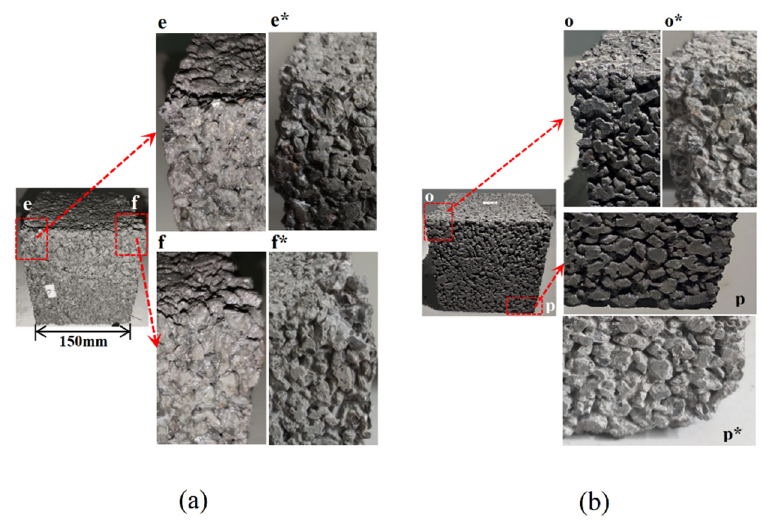
Figure 3. Change of pervious concrete morphology under different freeze-thaw cycles ( a ) aqueous solution; ( b ) salt solution; (e, f, o, p represent F-T 0 times, e*, f*, o*, p* represent F-T 100 times).